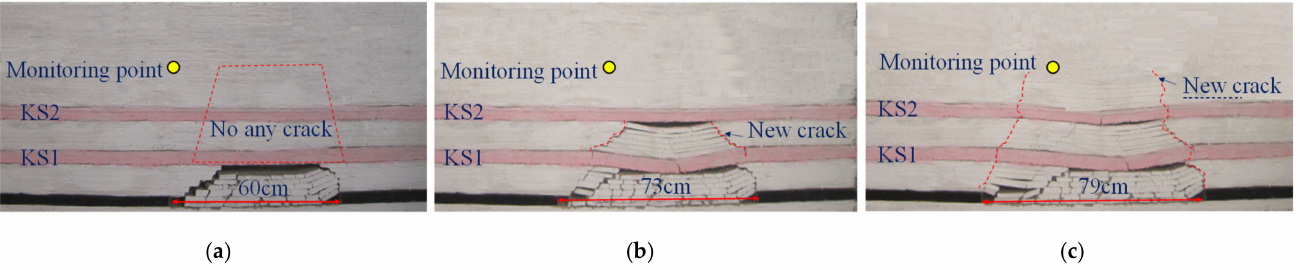
Figure 5. Strata breakage and movement between the scenarios without UCA: ( a ) advance 60 cm; ( b ) KS1 broken; ( c ) KS2